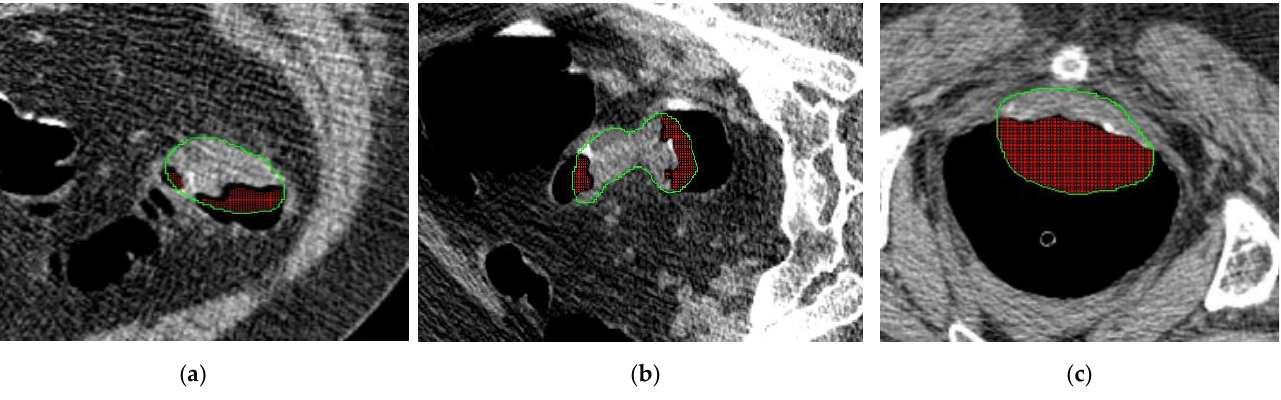
Figure 7. Three sample CT slices from select polyp masses. Green contour around the polyp show the segmentation. Air voxels from the lumen below − 450 HU are removed post-segmentation and are highlighted red in the images. Images show sample polyps with pathologies ( a ) adenocarcinoma, ( b ) villous adenoma, and ( c ) villous adenoma.